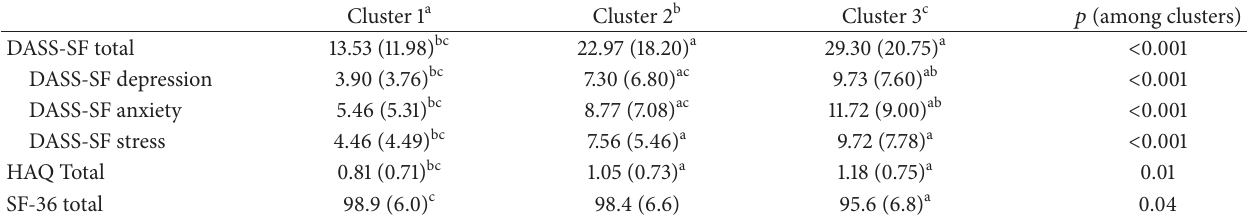
Table 2: Mean values (standard deviation) in mood, disability, and quality of life among the three cluster subgroups.